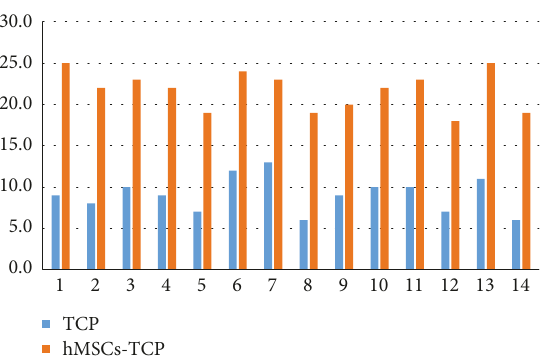
Figure 8: Representation of score values (vertical axis) of the subjects included in the study (horizontal axis). Score values for bone regeneration of TCP group (left femur) were clearly lower than those of the hMSC-TCP group (right